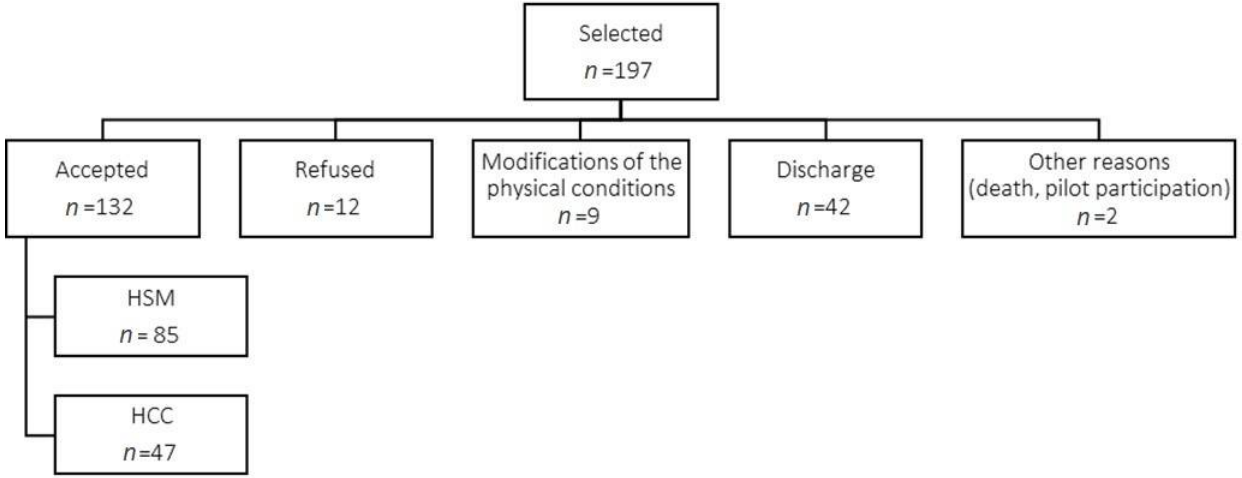
Figure 2. Final Sample Size. Legend: HSM—Hospital Santa Marta; HCC—Hospital Curry Cabral.